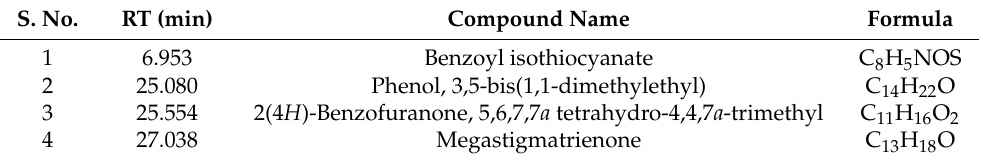
Table 1. Bioactive compounds of M. alba leaf extract (MLE) analyzed by GC–MS. S.